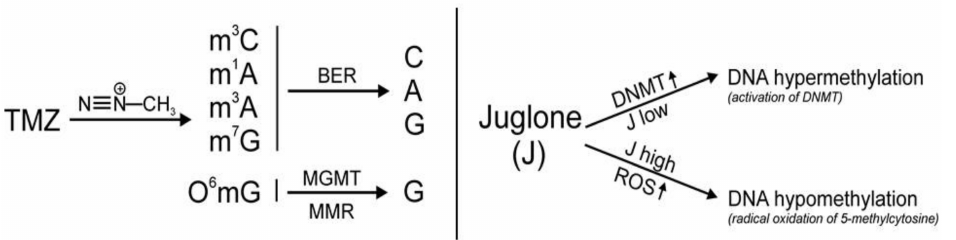
Figure 2. Mechanism of action of temozolomideTMZ and juglone BER-Base Excision Repair, MGMT- Methylguanine–DNA methyltransferase, MMR-Mismach Repair, DNMT-DNA methyl transferase, ROS-Reactive Oxygen